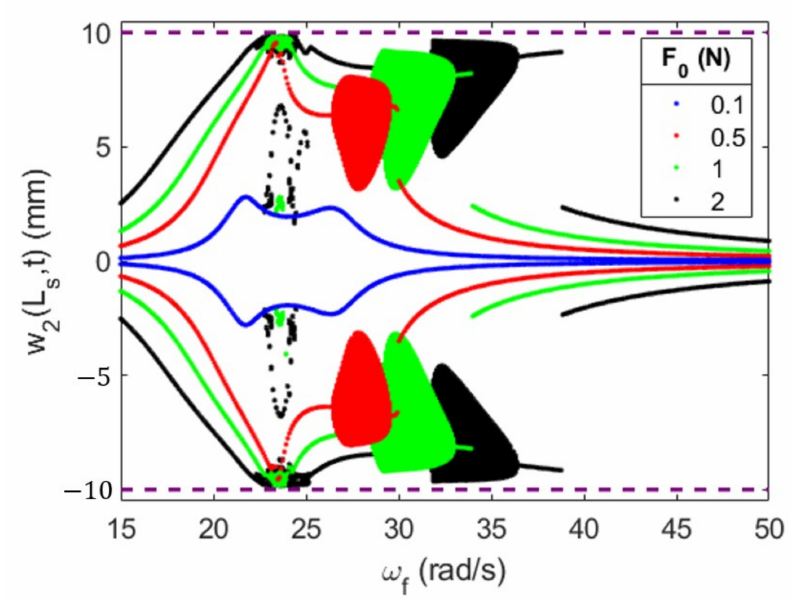
Figure 33. Bifurcation diagram of the absorber’s position with a gap of 10 mm, tip mass of 0.06 kg and substrate thickness of 0.4759